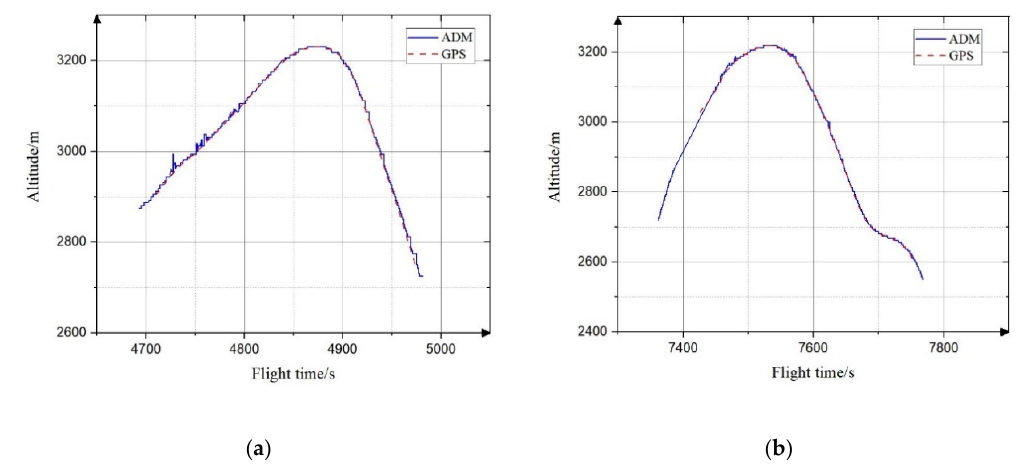
Figure 6. ADM valid data of ( a ) period 1 (4693 s–4983 s) and ( b ) period 2 (7362 s–7768 s). The Blue solid line represents ADM altitude, and the red dash line represents the reference height provided by GPS.